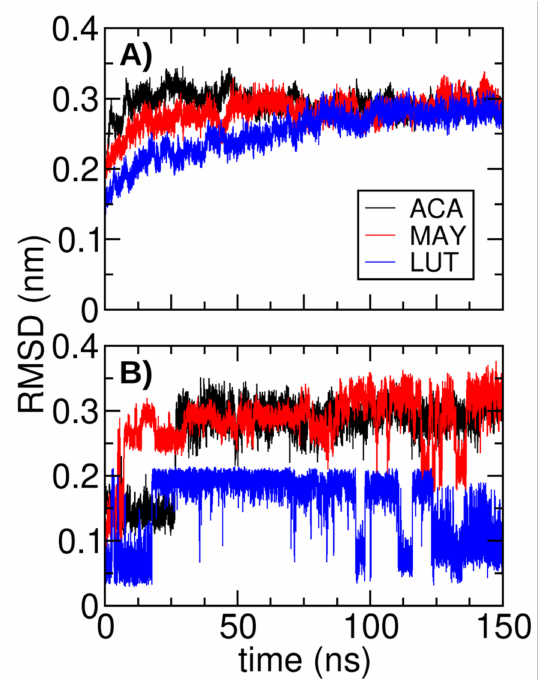
Figure 6. RMSD values of MD simulations ( A ) for the atoms of the complexes of acarbose (ACA), maysin (MAY), and luteolin (LUT) with maltase-glucoamylase (NtMGAM) ( B ) RMSD variations after 125 ns calculated over the atoms of the